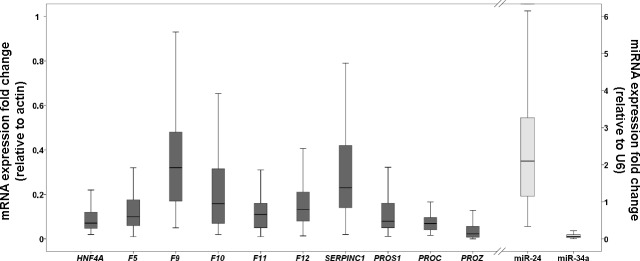
Hepatic expression profiles of mRNAs and miRNAs in human liver samples.Box plots indicate first and third quartiles of expression; the bold line in the box represents the median value; the whiskers represent the range.